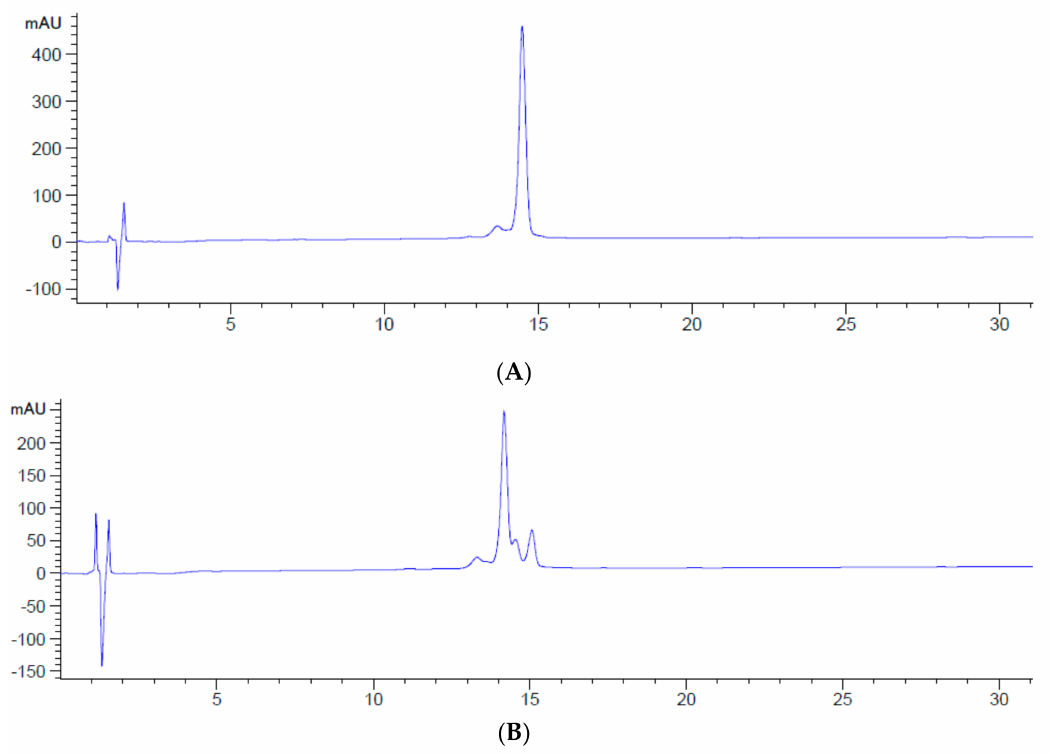
Figure 1. RP-HPLC chromatogram of (KG) 5 MOG 35–55 (Ser 42 ) (Pep 8) at 214.4 nm and 48 h after dilution; ( A ) dissolved in water, ( B ) dissolved in bicarbonate bu ff er pH 9.0. The deaminated product was revealed as a new peak to the right of the main